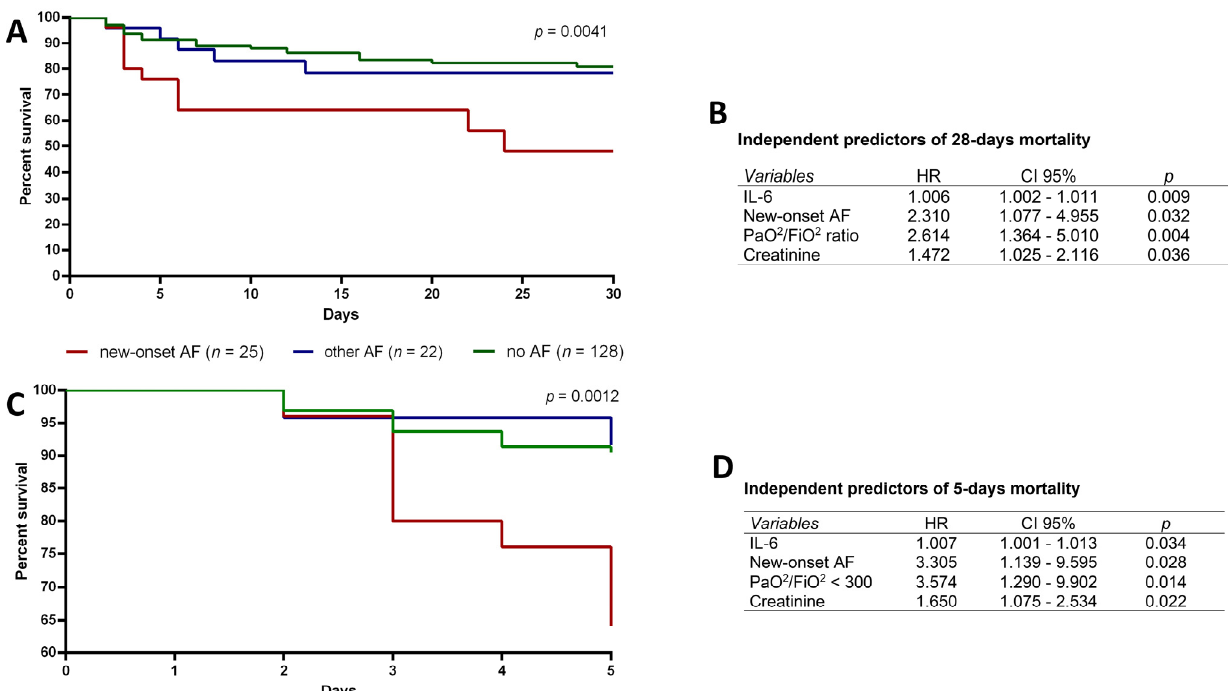
Figure 4. ( A – D ). Kaplan-Meier survival plot analysis for hospitalized COVID-19 patients with new- onset atrial fibrillation (new-onset AF, n = 25, red line), with other forms of AF (other AF, n = 22, blue line) and without AF (no AF, n = 128, green line) at 28 days ( A ) and at 5 days ( C ). Cox regression analysis results show that IL-6, creatinine, new-onset atrial fibrillation and PaO 2 /FiO 2 < 300 are in- dependent predictors of 28-days ( B ) and 5 days mortality ( D ).